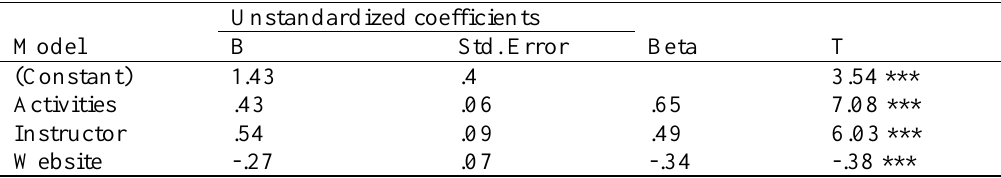
Regression Model of Activities, Instructor, and Website Prediction upon Overall